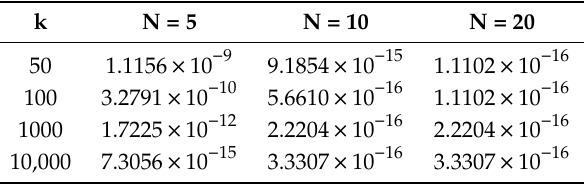
Table 2. Absolute error for κ = 0, bounded at x = −